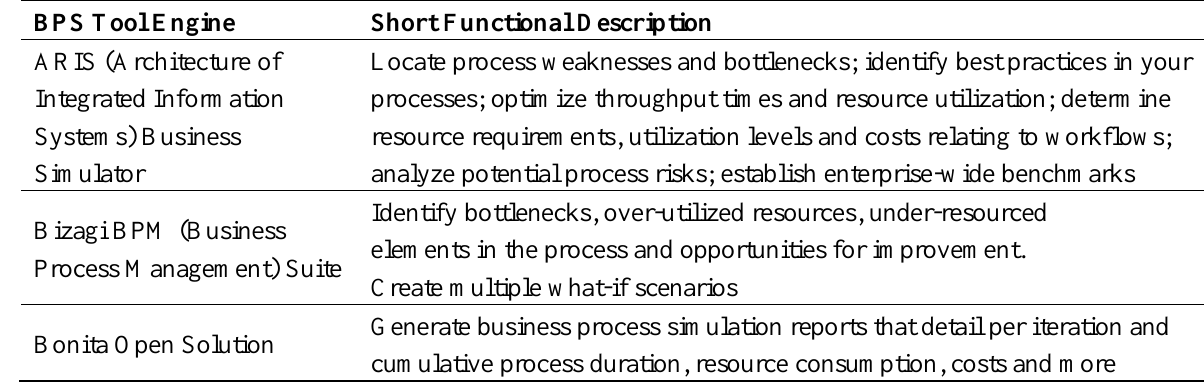
Table 3. A summary of commercial business tools supporting